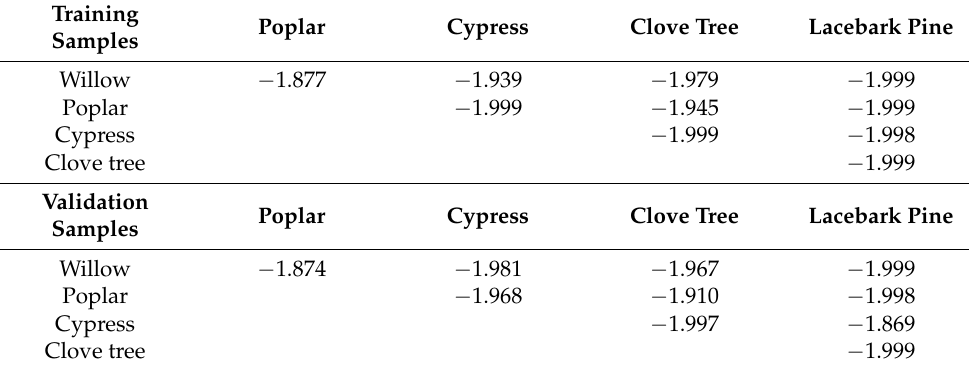
Table 6. Transformed divergence of samples.